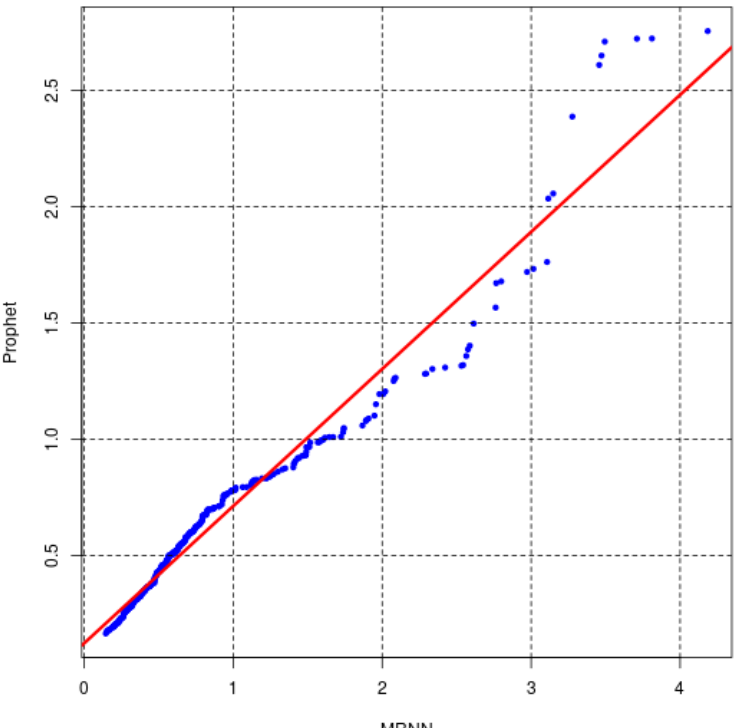
Figure A13. QQ plot between MRNN and Prophet on dataset Electricity with quality measure MASE overall horizons.